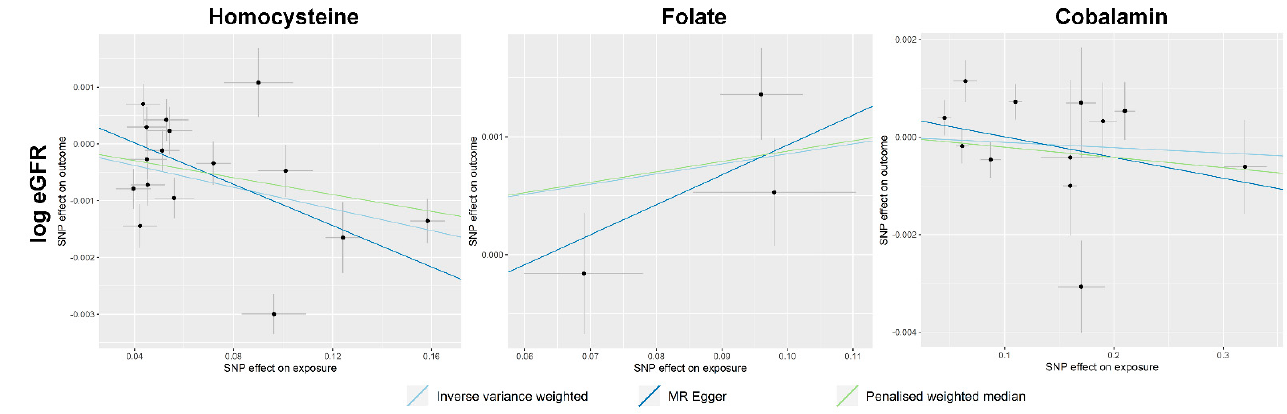
Figure 2. Scatter plots showing the results for summary-level Mendelian randomization analysis results. The x-axes indicate the effect for exposure variables, and the y-axes indicate the effect for outcome (log-transformed eGFR). The analysis was performed for 567,460 individuals of European ancestry of the CKDGen consortium. Table 2. Summary-level Mendelian randomization results with the CKDGen